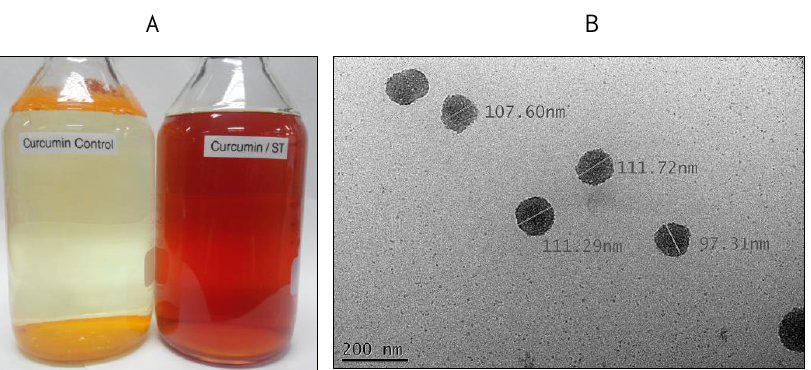
Figure 1. ( A ) Curcuminoids dissolved in water and in 10% ( w / v ) stevioside. ( B ) Field-emission transmission electron microscope (FE-TEM) image of curcuminoid–stevioside nanoparticles in the 10% ( w / v ) stevioside.